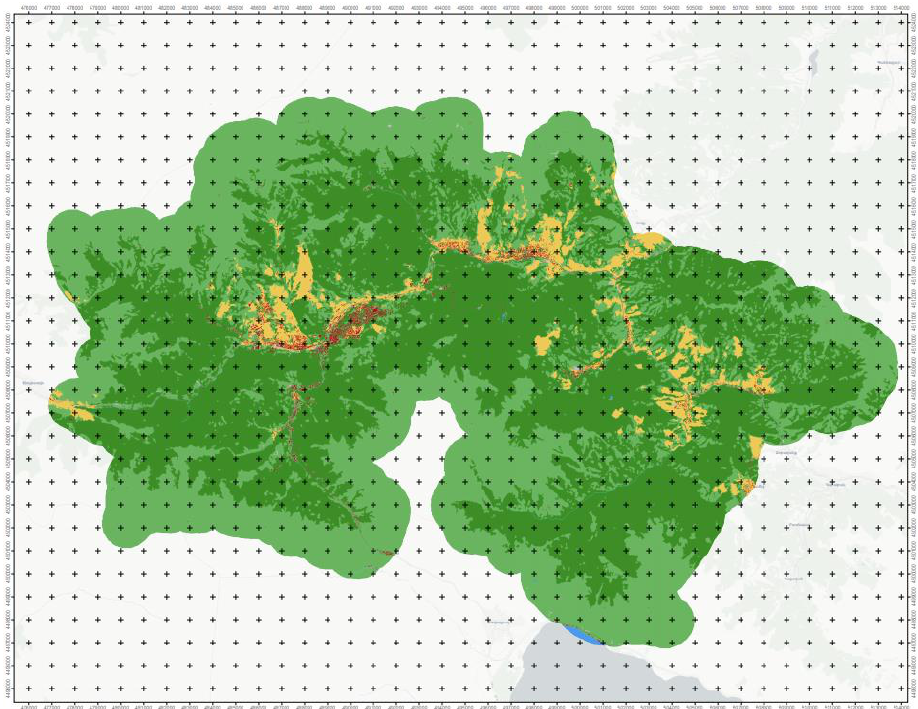
Figure 13. Dilijan National Park, Armenia: Land Cover Land Use Map 2019 based on Sentinel-2 data (10 m).